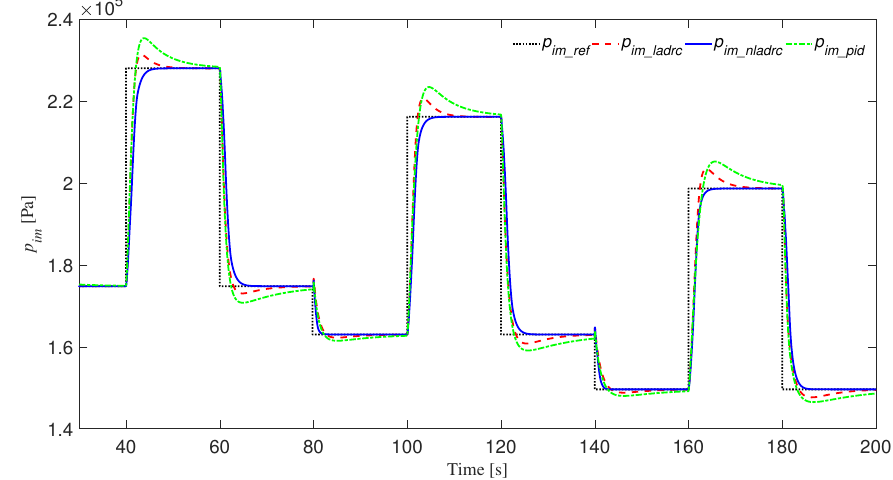
Figure 11. The response curve of intake manifold pressure at different engine